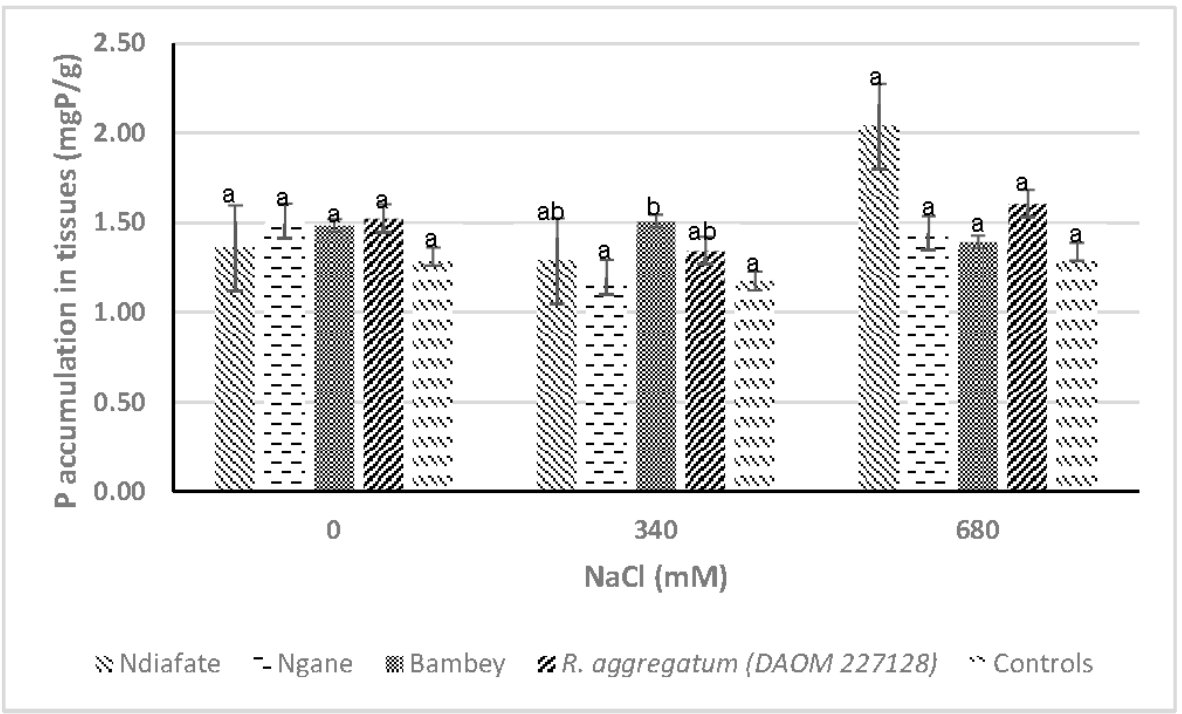
Figure 7. Effect of the AMF isolates × NaCl interaction on the accumulation of P in tissues after 30 days of culture. Ndiafate, Ngane, and Bambey correspond to high, moderate, and low salinity zones, respectively where the AMF were collected. Bars with the same letters for each variable are not significantly different at p < 0.05 (Newman–Keuls test) and error bars represent standard error of the mean ( n = 270).